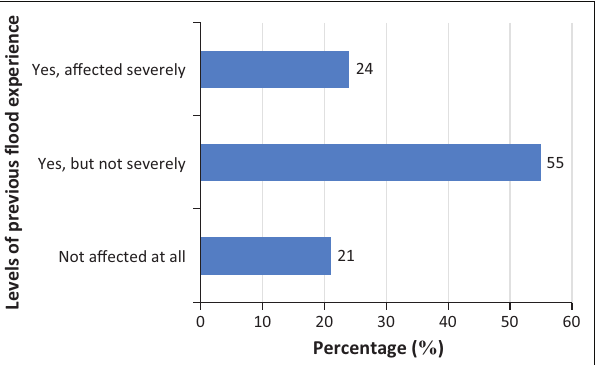
FIGURE 4: Percentage of respondents’ flood events